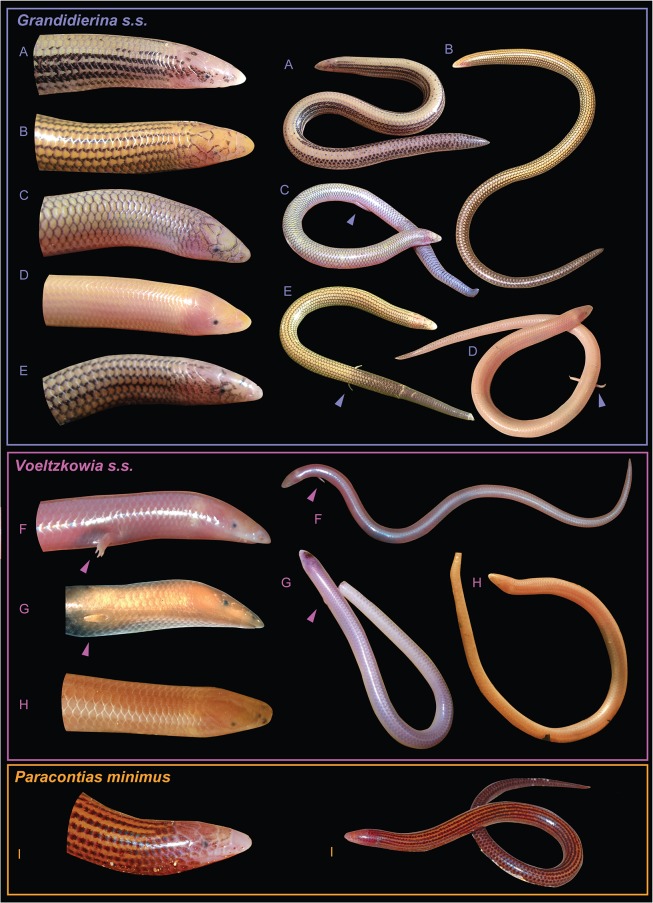
Convergent external morphology of the three clades of Malagasy skinks of the sand-swimming ecomorph.Photographs of (A) Grandidierina rubrocaudata* from Sakabera, (B) G. lineata* from Faux Cap, (C) G. fierinensis*, dark phenotype from Tombohina, and (D) pale phenotype from Anakao, (E) G. petiti* from Sakabera, (F) Voeltzkowia yamagishii** from Ankarafantsika, (G) V. mobydick** from the Bongolava plateau, (H) V. mira from Antsanitia, and (I) P. minimus from the baie de Sakalava. Arrows indicate limbs. All except G represent living specimens. Photographs from A. Miralles, F. Eckhard, A. Rakotoarison and J. Köhler. * Species included in the genus Voeltzkowia until the present study; ** Species included in the genus Sirenoscincus until the present study (see taxonomic accounts in Discussion).